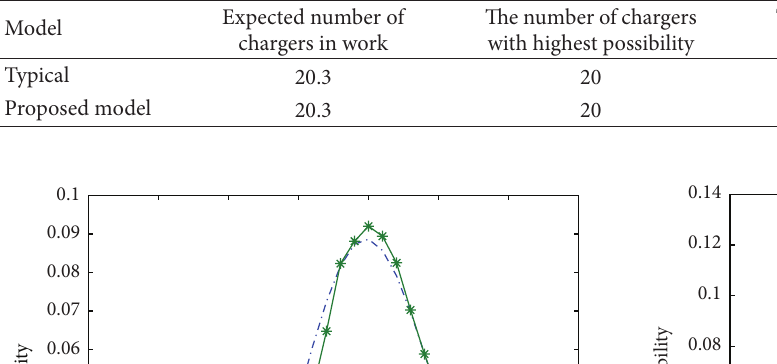
Table 4: Parameters of the probability distribution of station state.